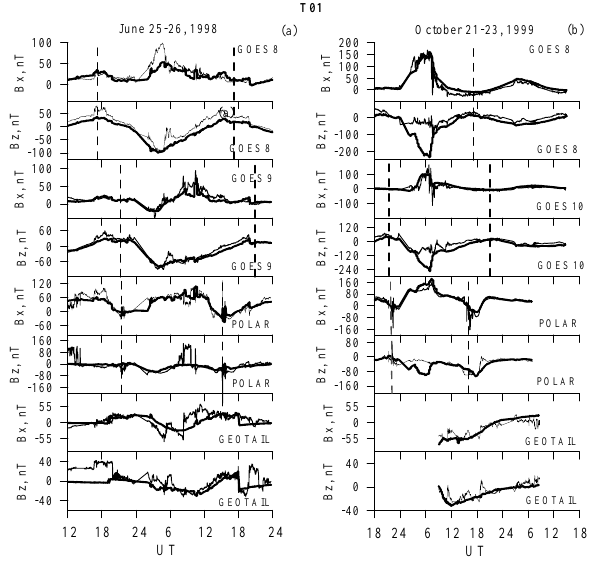
Fig. 5. Observed and model magnetic fields in the same format as in Fig. 3 for the the empirical T01